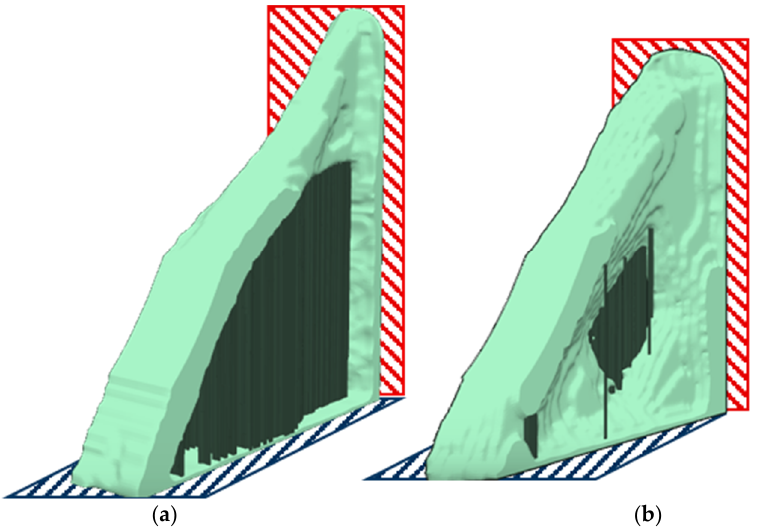
Figure 10. Comparison of the reference design proposal ( a ) and the design proposal with the highest effective material usage ( b ) for the bracket application example. The support-material is displayed in dark green, while constraints are visualized in dark blue and loaded areas in red.